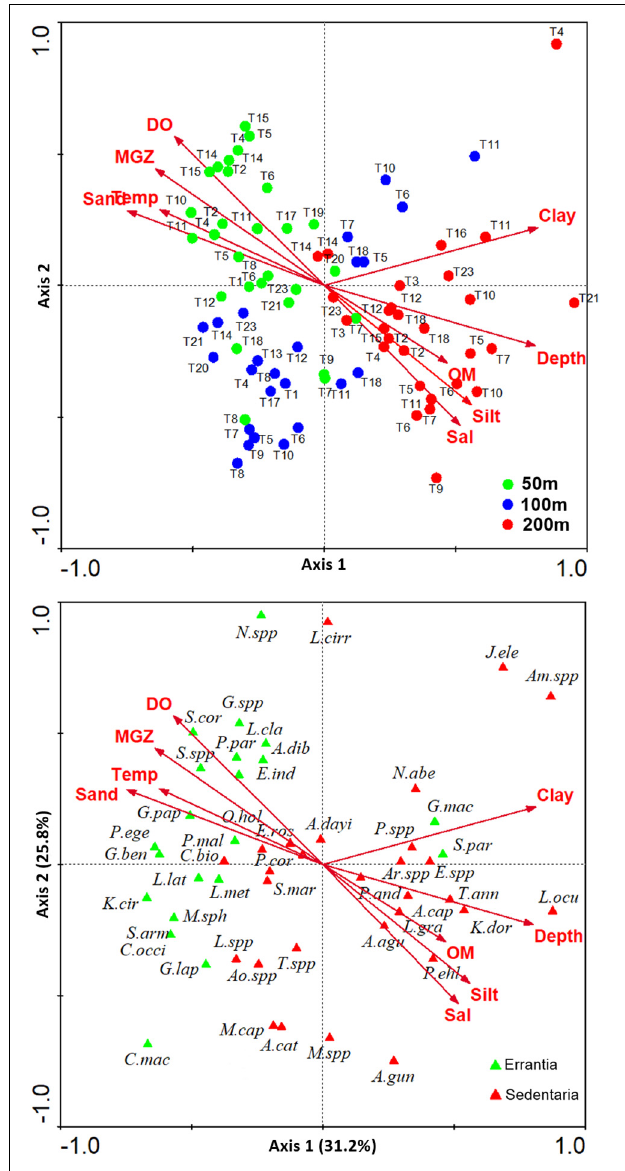
FIGURE 10 | Canonical Correspondence Analysis (CCA) bi-plots showing ordination of (A) sampling sites at 50 m (green), 100 m (blue), and 200 m (red) depth strata, and (B) selected polychaete species (errant polychaete species represented by green triangle and sedent polychaete species by red triangle) with respect to environmental parameters (arrows: Temp-Temperature, Sal-Salinity, DO-Dissolved oxygen, Sand, Silt, Clay, MGZ-Median grain size, OM-Organic matter). See Supplementary Table S7B for abbreviations of polychaete species